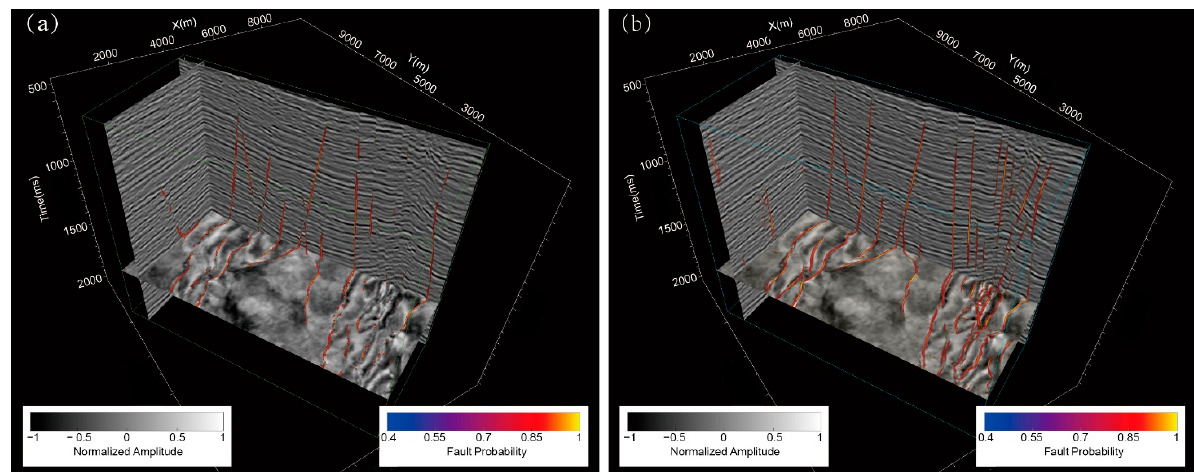
Figure 7. The first 3D seismic data are displayed with faults probabilities that are predicted by using ( a ) the pre-trained U-Net model and ( b ) the U-Net model after transfer learning.